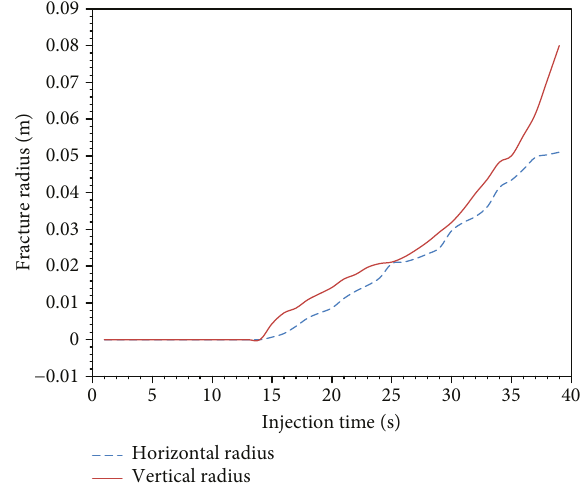
Figure 13: Development of horizontal and vertical fracture radii versus injection time in the vertical jointed